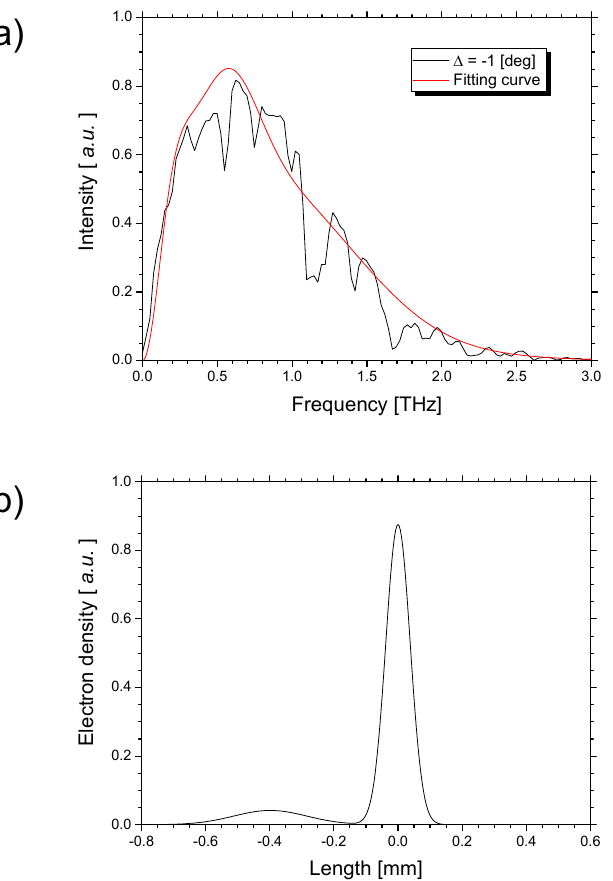
Figure 10. ( a ) Calculated CER spectrum in the satellite pulse model (red curve) and the measured CER spectrum for ∆ = −1° (black curve). The parameters σ S , ∆ p , r c are 3 σ M , 10.5 σ M , and 0.15, respectively. ( b ) Electron distribution at the aforementioned parameters in the satellite pulse model.